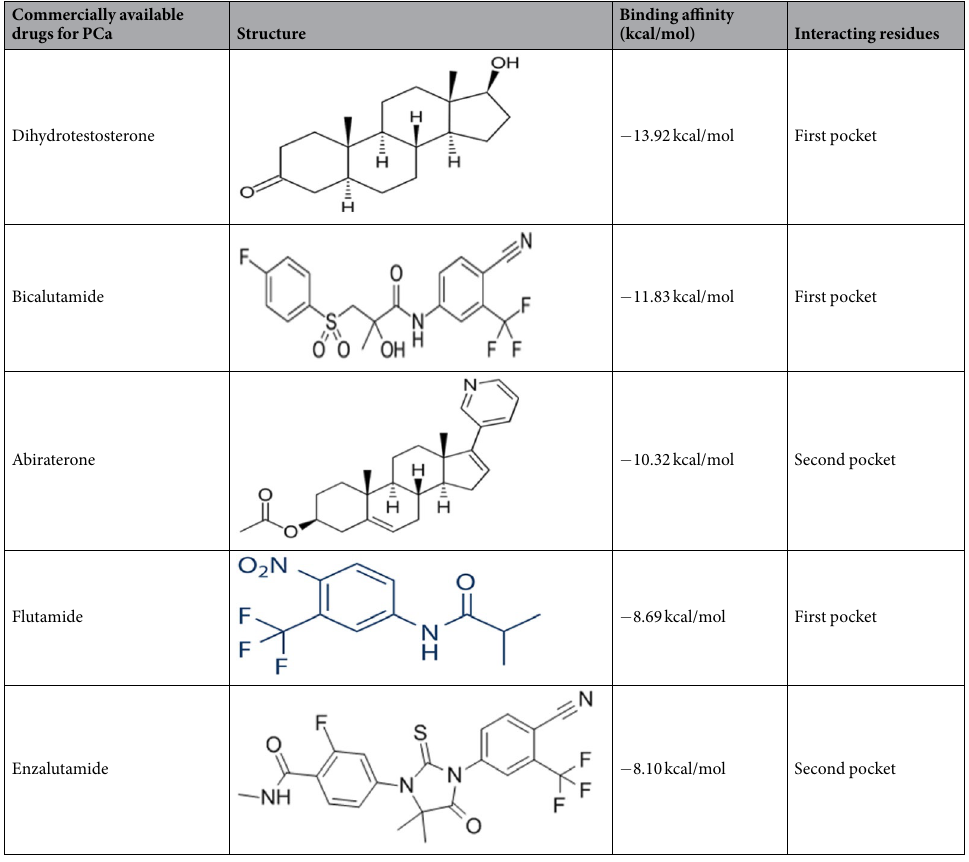
Table 2. Binding affinity energies and the interacting catalytic sites of the commercially available PCa